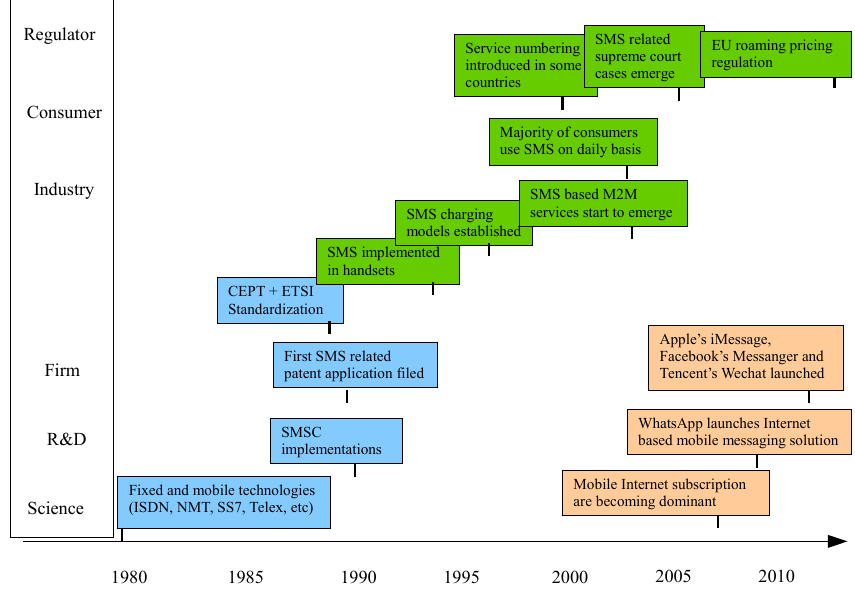
Fig. 5-b. Consumer applications related events on the timeline on the different layers of the Disruption